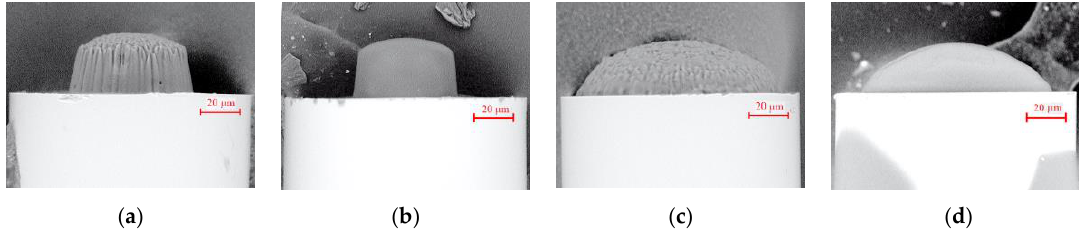
Figure 2. Scanning electron microscope images of optimal microtips prepared by: ( a ) LASER 532 on MMF62.5; ( b ) UV LED on MMF62.5; ( c ) LASER 532 on MMF105; ( d ) UV LED on MMF105. Manufacturing parameters: optical power—30 μW and exposition time—30 s.